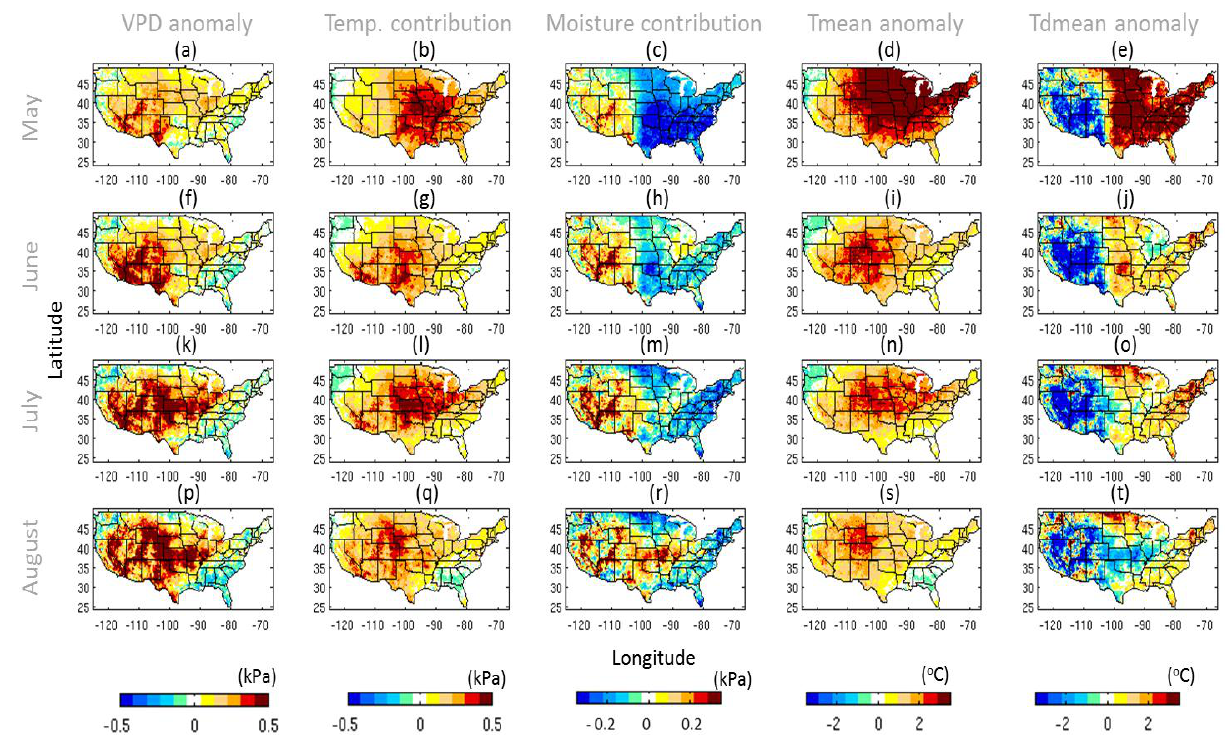
Figure 6. Development of 2012 Midwest US drought and the contribution of temperature and humidity in forming high evapotranspiration demand inferred by VPD. From left to right columns represent 3 month ( a ) VPD anomaly (kPa); ( b ) temperature contribution to evapotranspiration demand; ( c ) humidity contribution to 2012 evapotranspirational demand; ( d ) Tmean anomaly; and ( e ) Tdmean anomaly. Similar to Figure 3, the maps correspond to (a–e) May, ( f – j ) June, ( k – o ) July, and ( p – t ) August of 2011. Anomalies are calculated based on 3-month averages (of a given month and prior 2 months) relative to the corresponding climatology derived from the entire